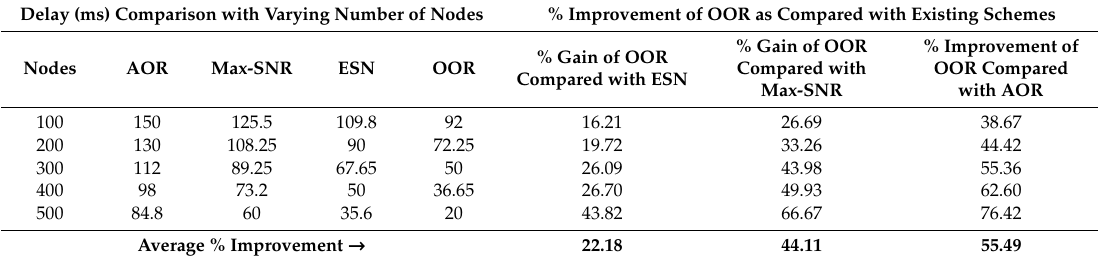
Table 1. Descriptive observations of OOR performance in terms of delay.